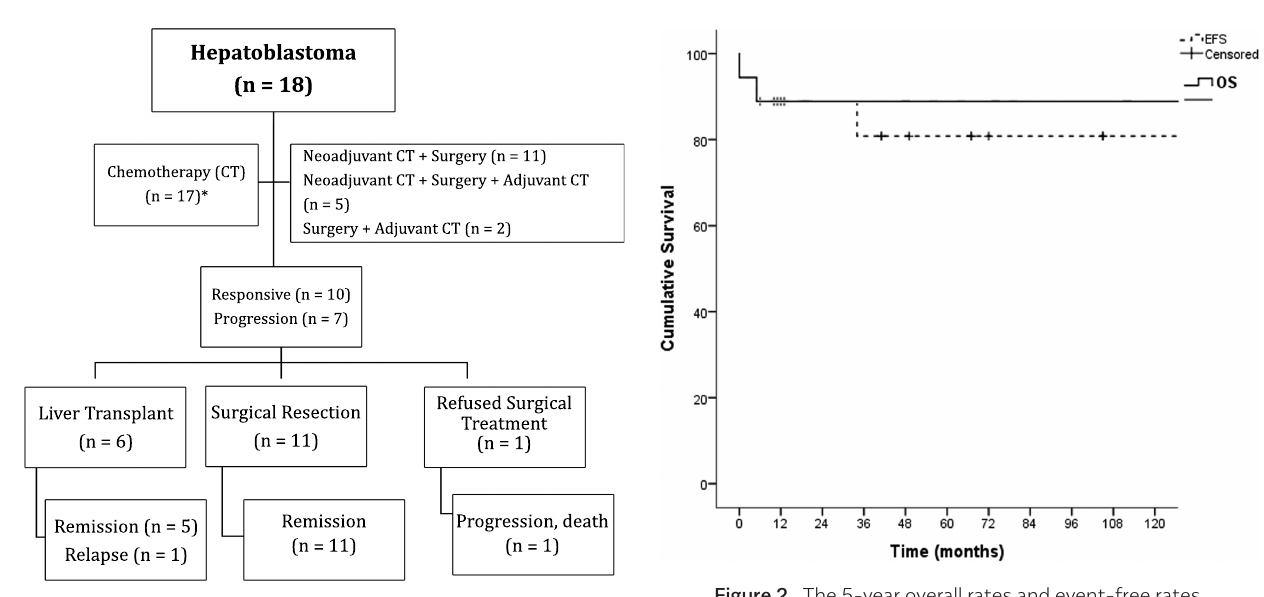
Figure 1. Flowchart of the treatments and outcomes of patients with hepatoblastoma. * One patient died without receiving chemotherapy or surgery due to tumor rupture at the start of the first course of chemotherapy.